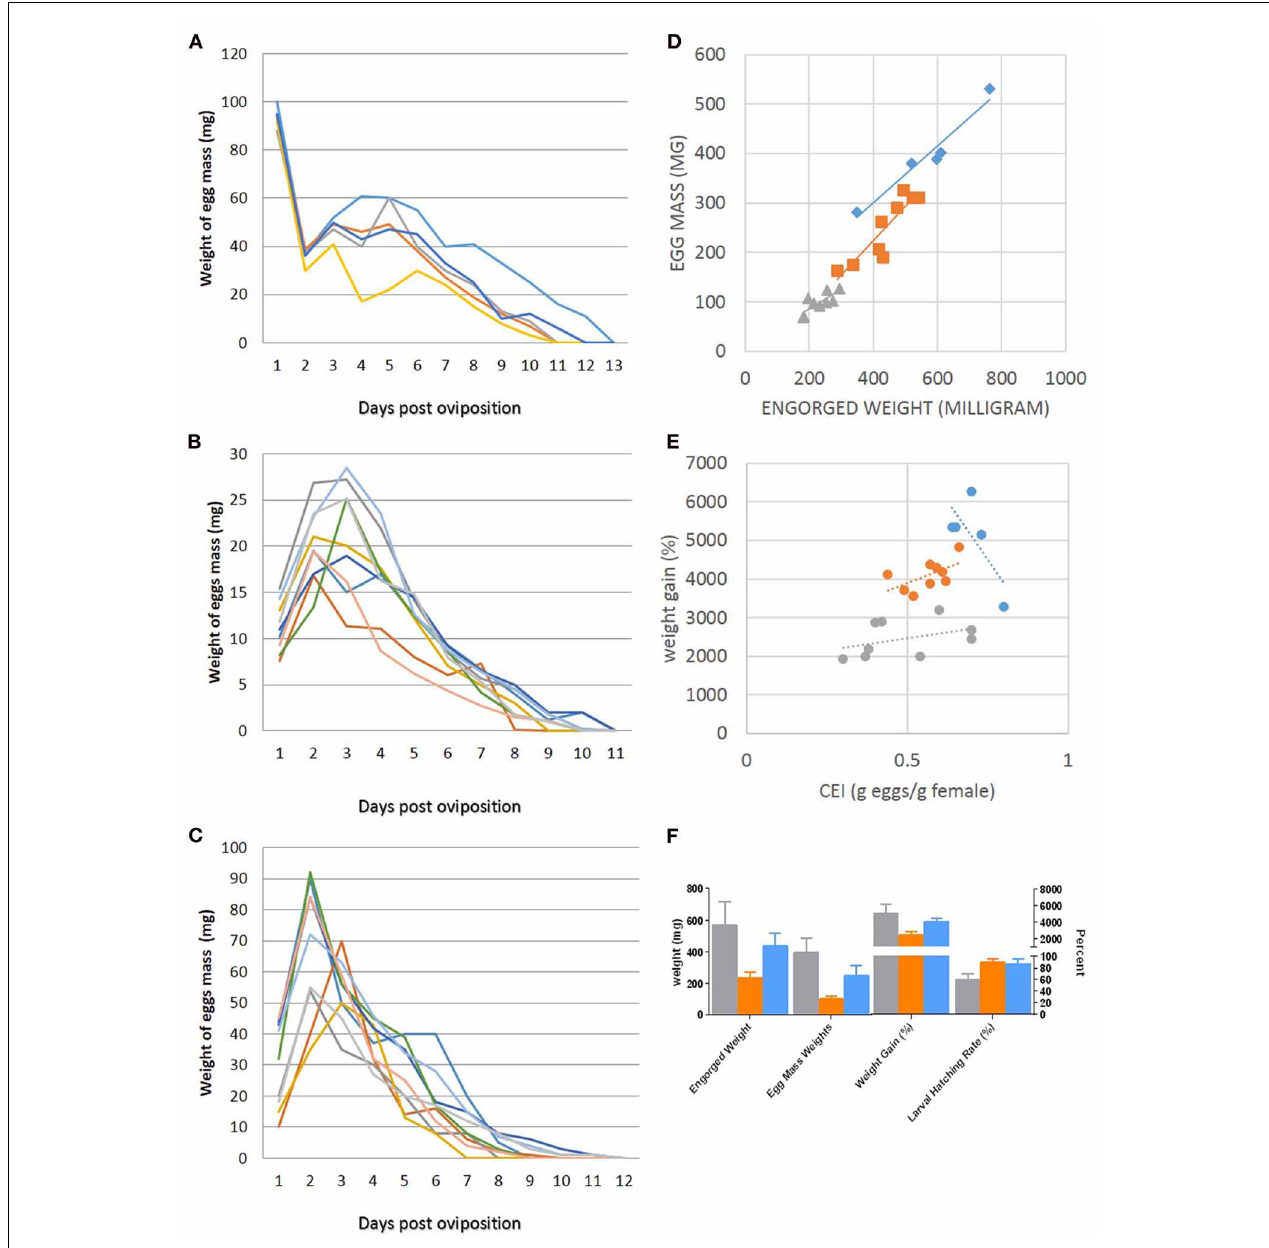
FIGURE 4 | Summary of oviposition data (A–F). Newly deposited egg mass weights measured daily of the females fed on mice (A) , guinea pigs (B) , and rabbits (C) . Each color represents an individual female. Comparisons of egg mass to engorged weight (D) and weight gain to conversion efficiency